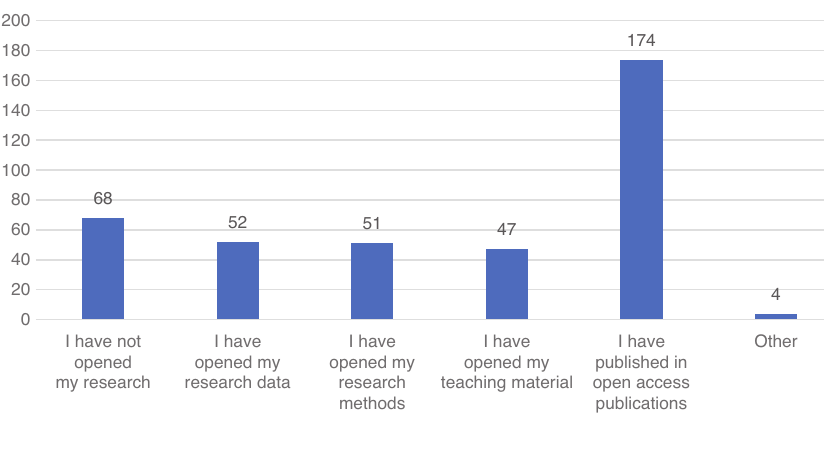
Fig. 6: What resources have the respondents opened (N=261